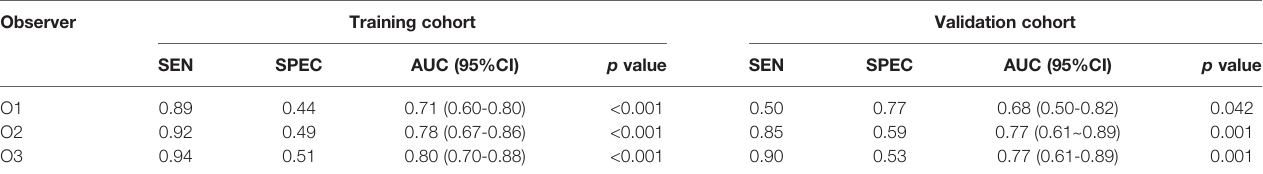
TABLE 1 | Performance of the three observers of BI-RADS analysis.